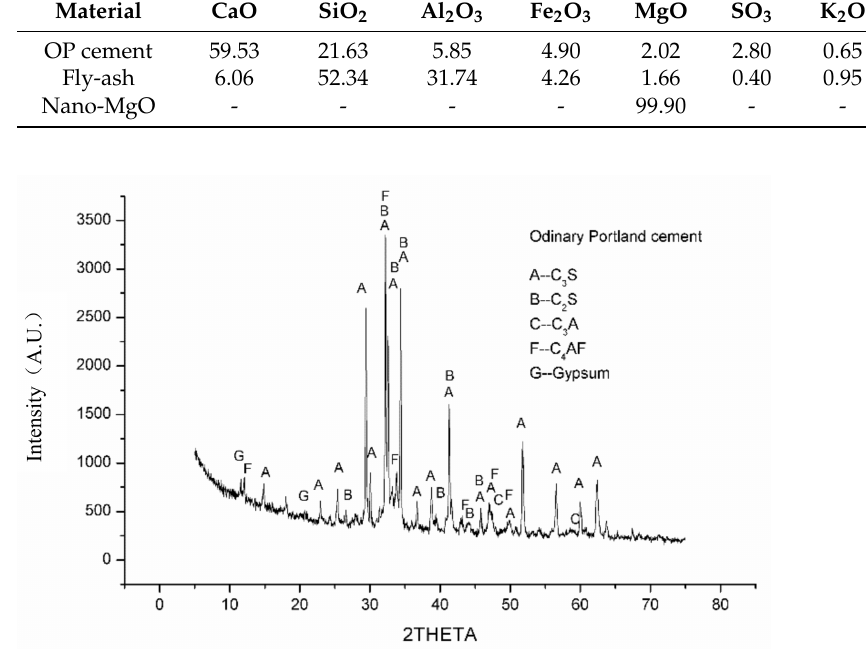
Figure 1. XRD pattern of ordinary Portland